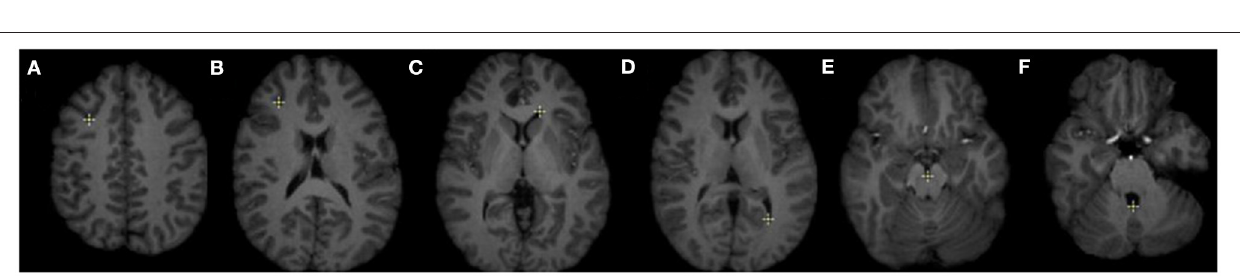
FIGURE 8 | (A) Plot of Hausdorff Distance (HD) errors of Table 4 . Brain shift: cases 1–7; partial resection: cases 8–12; total resection: cases 13–25; supra total resection: cases 26–30. (B) End-to-end execution times for registration from preoperative to intraoperative images (excluding B-Spline times of more than about 8min). All registration methods were run in parallel on 12 hardware cores on a DELL workstation with 12 Intel Xeon X5690@3.47 GHz CPU cores and 96 GB of RAM. Execution times include I/O. The mesh generation time is excluded from the PBNRR (preoperative step) but is included in the A-PBNRR (intraoperative step).